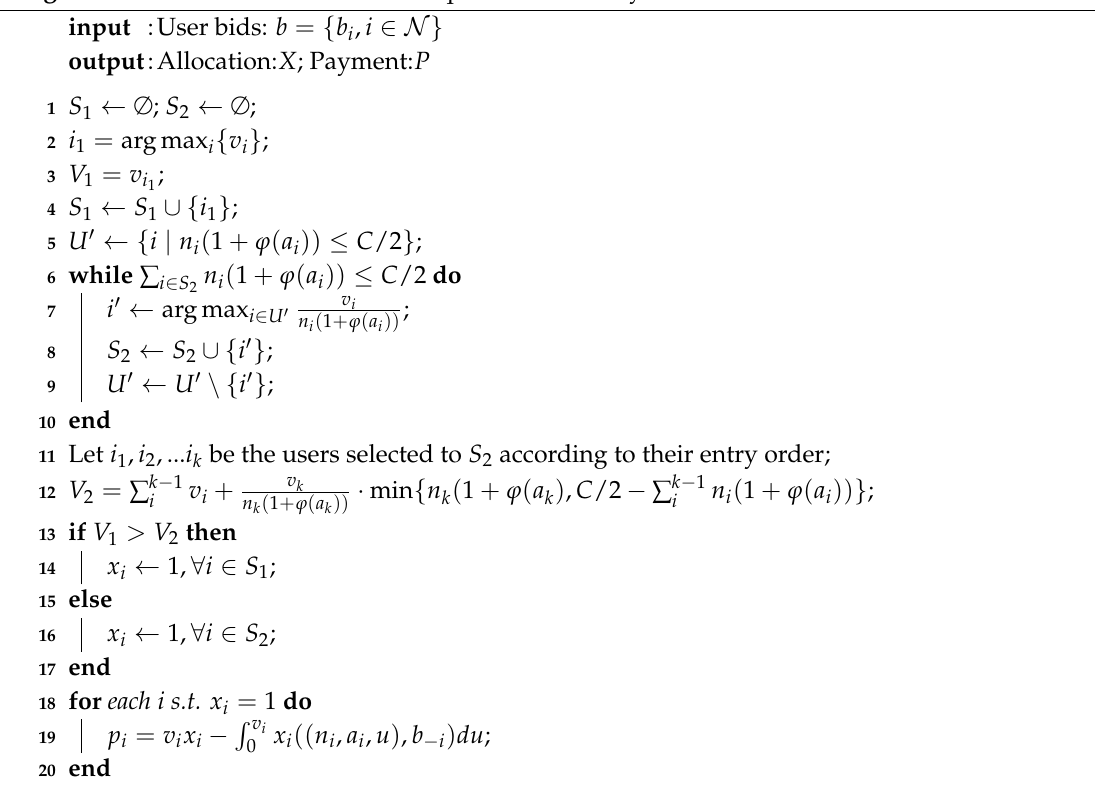
Algorithm 1: Auction for multi-unit request: